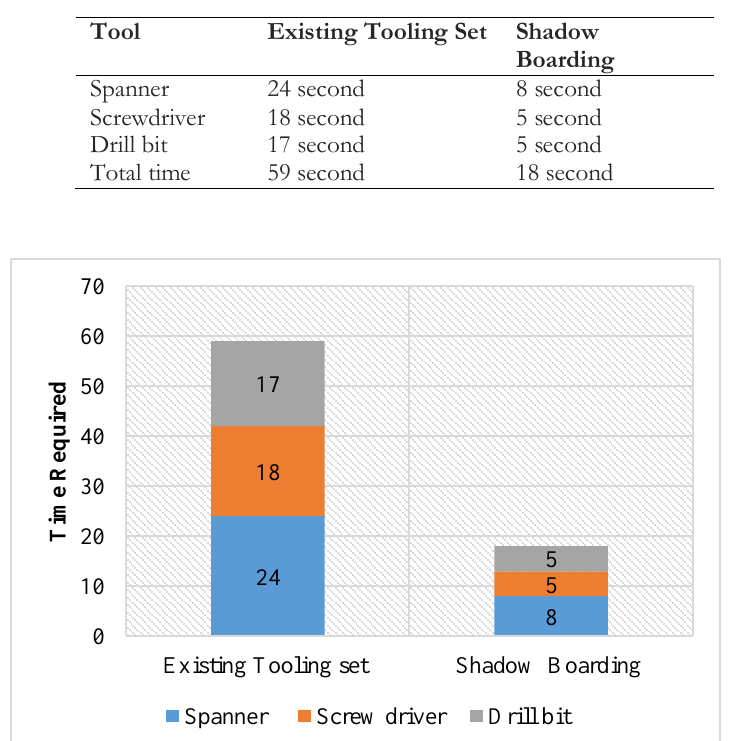
Fig. 4. A cluttered diagram showing direct comparison of time consumption study of existing tooling set and shadow